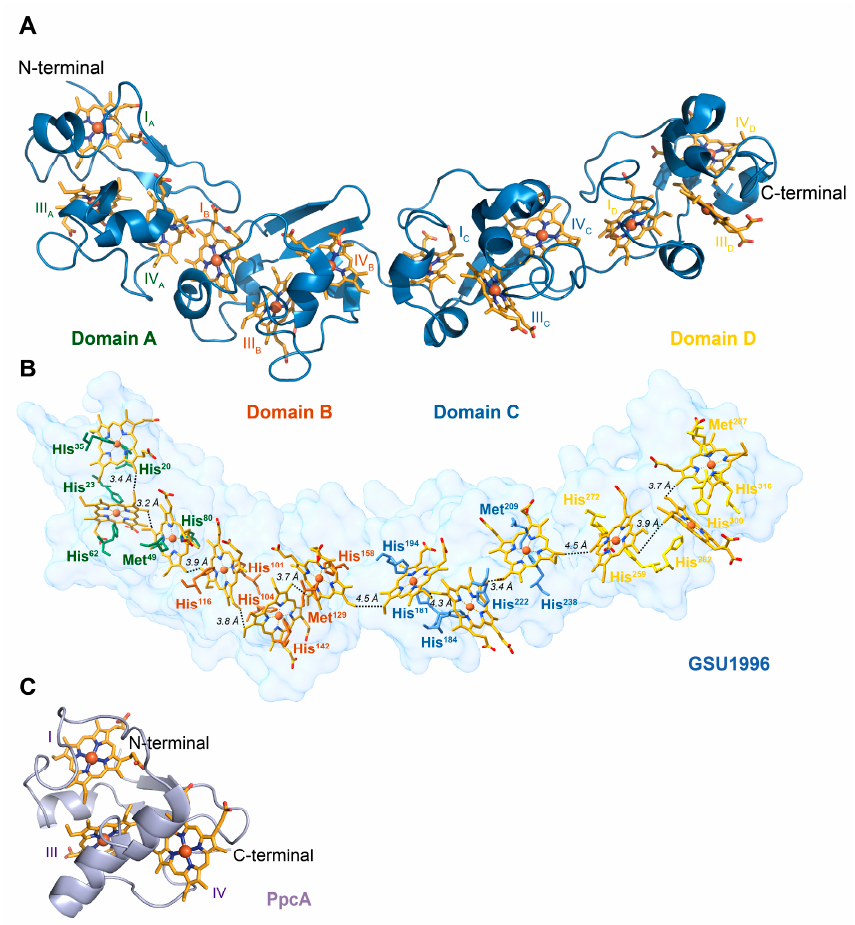
Figure 1. Structure of the cytochrome GSU1996 (PDB code 3OV0 [15]) and the triheme cytochrome PpcA (PDB code 2LDO [21]) from Geobacter sulfurreducens . In the structures, the heme groups are colored orange. Hemes are numbered I, III and IV according to the order of their attachment to the CXXCH motifs in the polypeptide chain to maintain consistency with the literature [15,22]. ( A ) Structure of cytochrome GSU1996 highlighting each triheme domain (A–D). ( B ) Surface representation of cytochrome GSU1996 showing the heme axial ligands and the heme array with the minimum observed distances indicated between adjacent porphyrin rings. ( C ) Structure of triheme cytochrome PpcA.